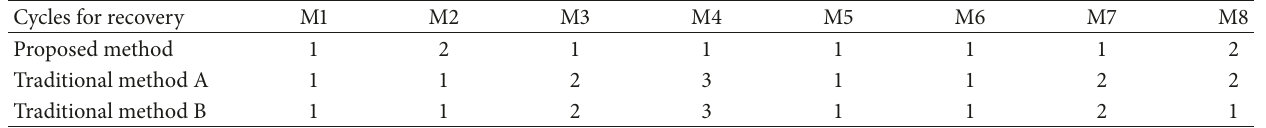
Table 3: Number of cycles required for